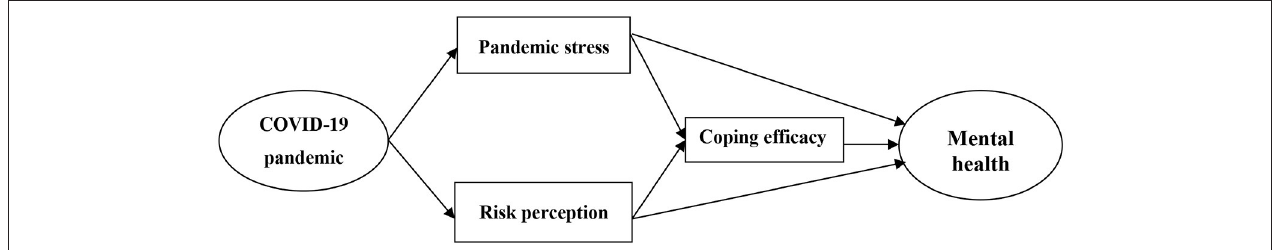
FIGURE 1 | The relationship model of pandemic stress, risk perception, coping efficacy, and mental